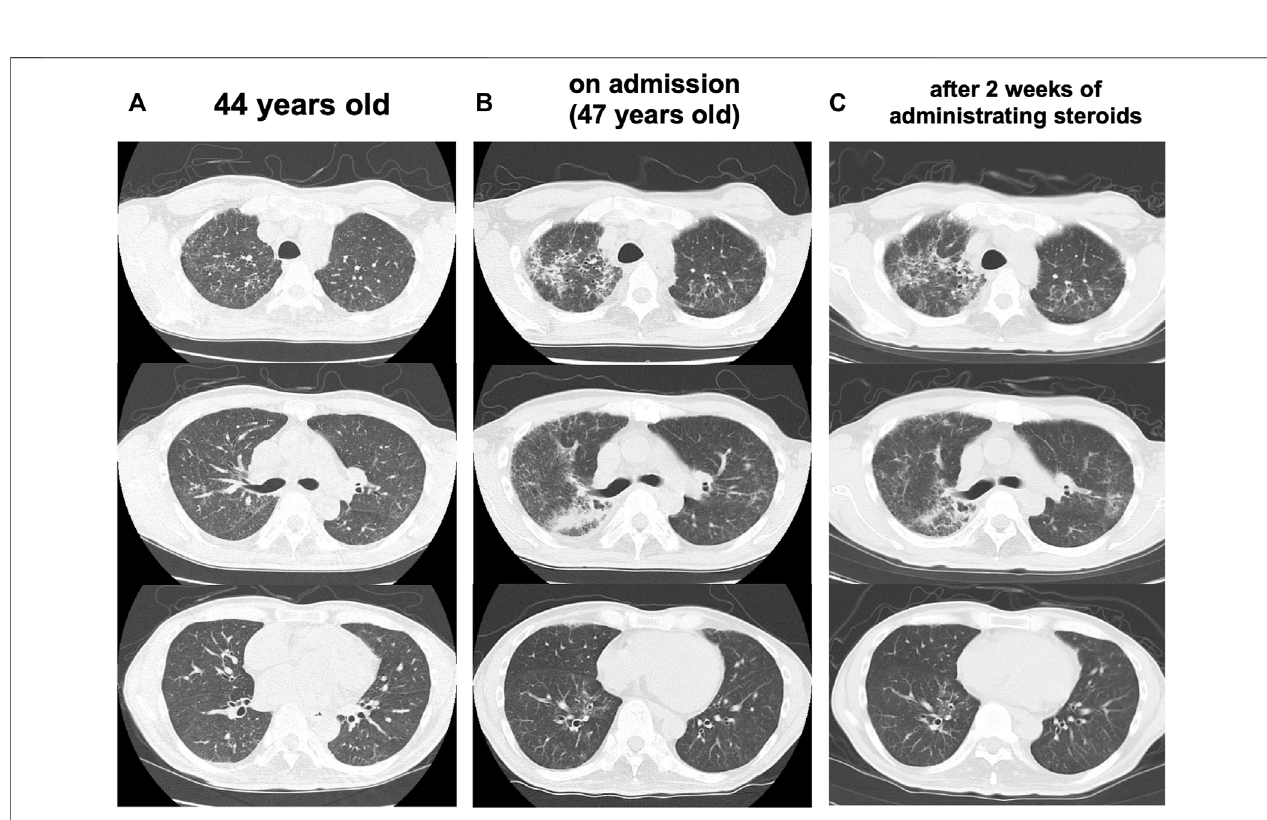
FIGURE3| Progress oflungCTscans (A) At44 yearsold (B) Onadmission(47 yearsold),theinterstitiallungshadowsworsened (C) 2 weeksafter administrating corticosteroids, interstitial shadows were improved.